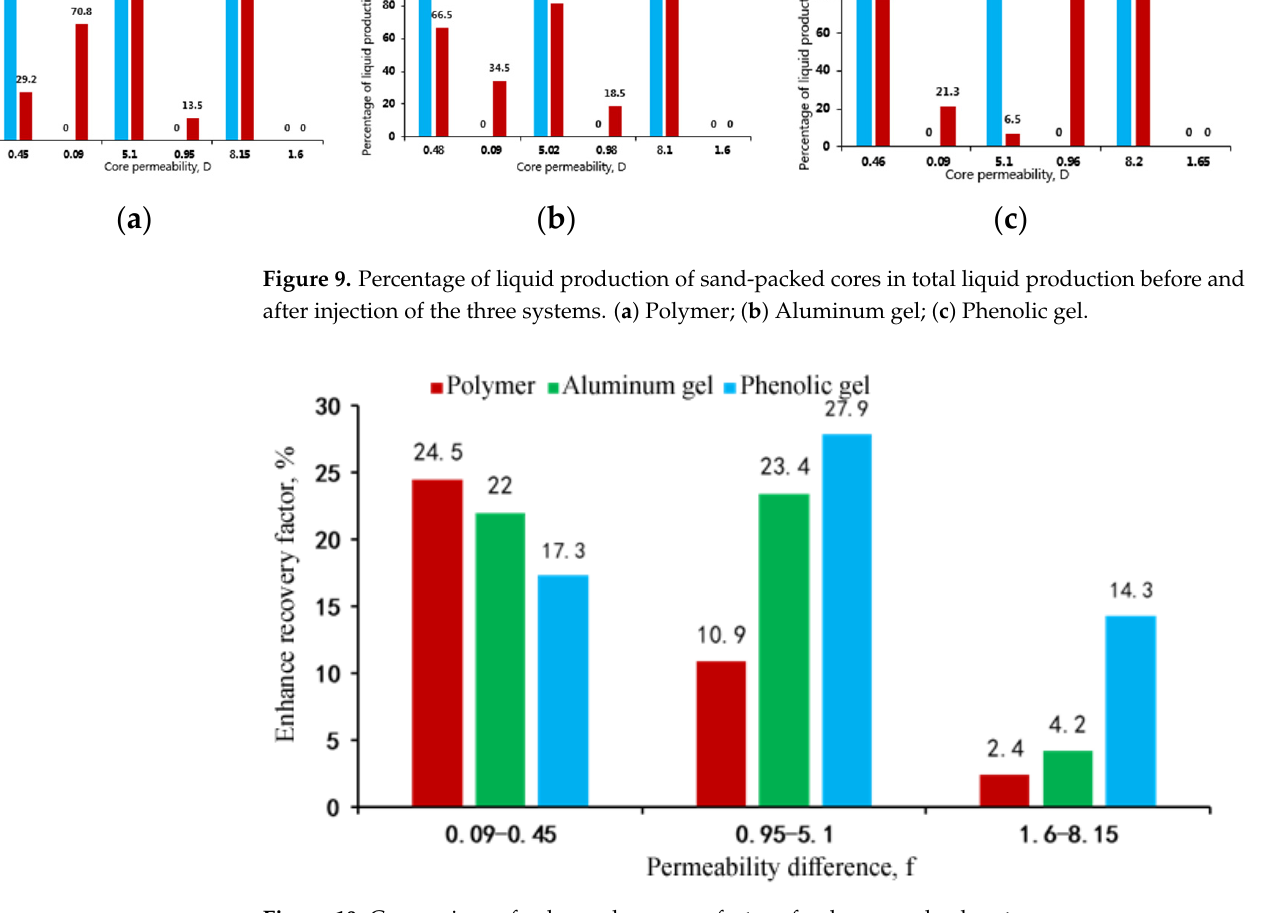
Figure 10. Comparison of enhanced recovery factor of polymer and gel systems .